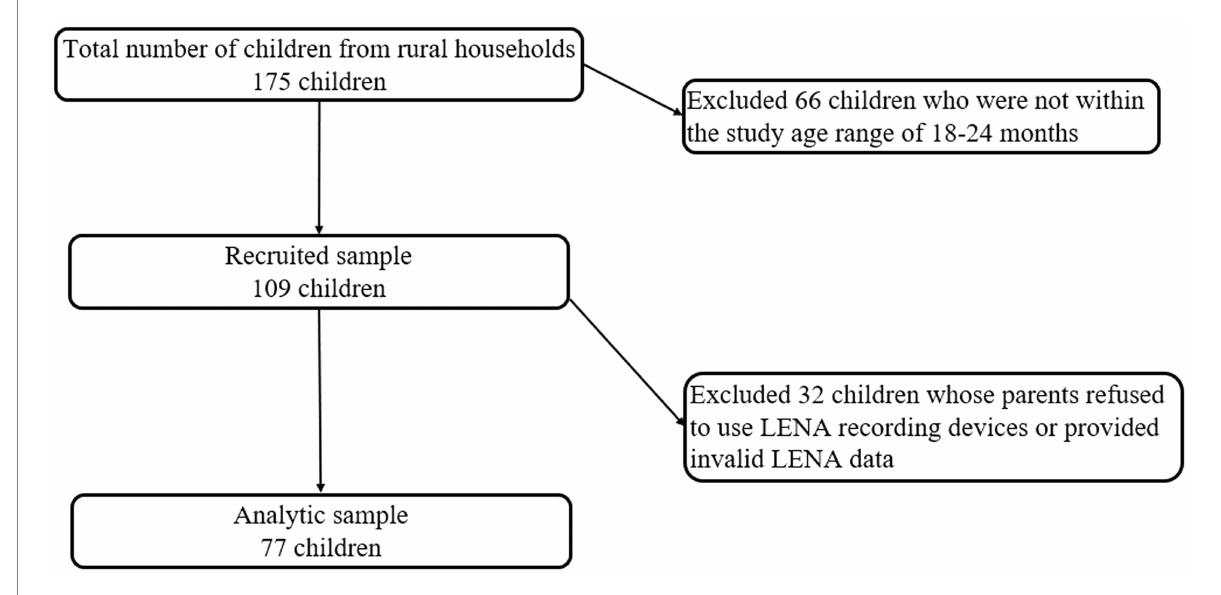
FIGURE 1 Sampling flowchart for rural children and household